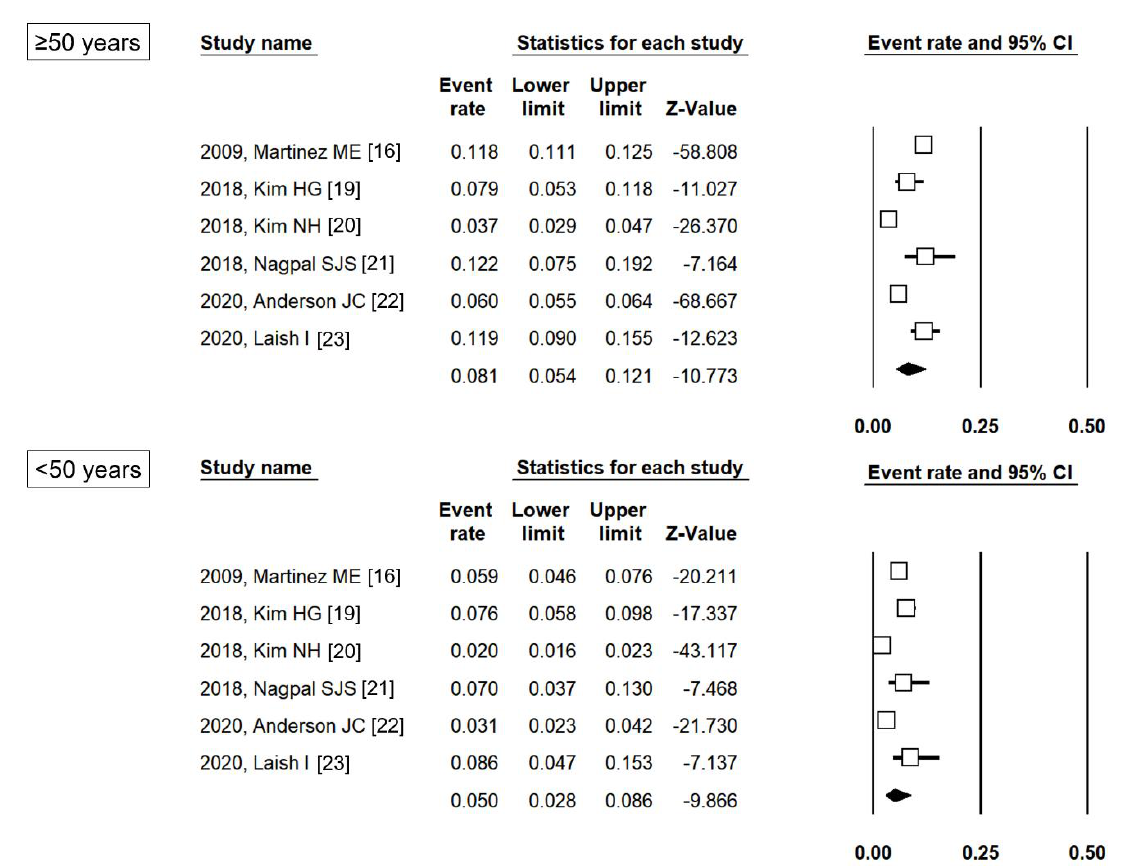
Figure 2. Pooled proportion of patients with metachronous ACRN according to age group. ACRN, advanced colorectal neoplasia; CI, confidence interval.